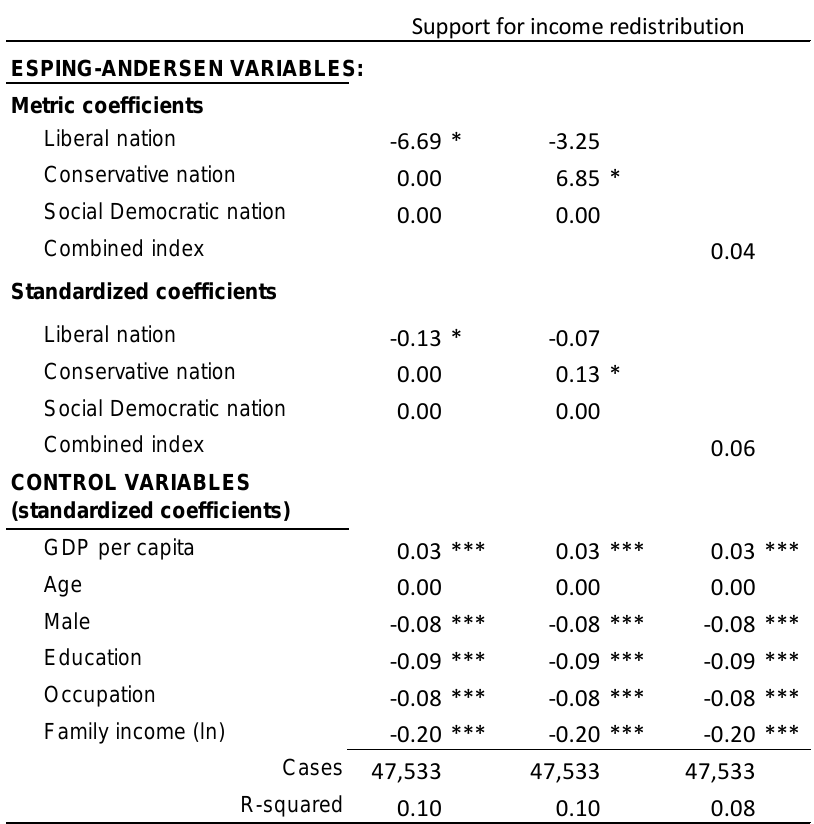
Figure A3. Effects of Esping-Andersen’s classification on attitudes toward income redistribution with Esping-Andersen’s typology (Liberal nations/ Conservative/ Social Democratic) expressed alternatively as dummy variables (columns 1 and 2) or an index scored 0/.5/1 (column 3). Multilevel regression estimates for 19 nations, 1987–2009.